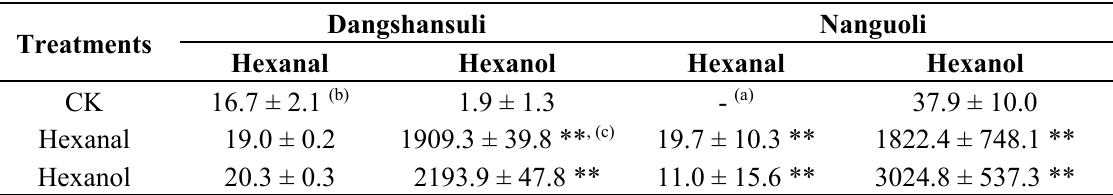
Table 2. Hexanol and hexanal contents (ng·g − 1·FW) of pear fruits fed on hexanol and hexanal; (a) -, not detected. (b) Values represented means ± SD of three replicates. (c) ** denoted significant differences between treatments and CK at the level of 0.01, according to Duncan’s